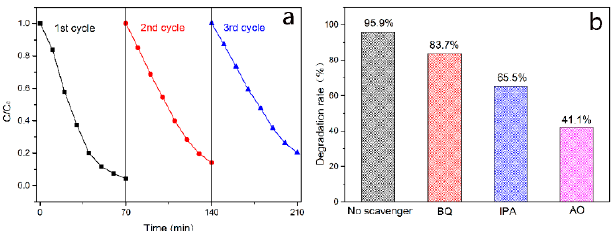
Figure 9. Stability study on the photocatalytic degradation of RhB over Ag 3 PO 4 /SnO 2 /CC heterojunction ( a ). Photocatalytic activities of the Ag 3 PO 4 /SnO 2 /CC heterojunction for the degradation of RhB in the presence of different scavengers ( b ).